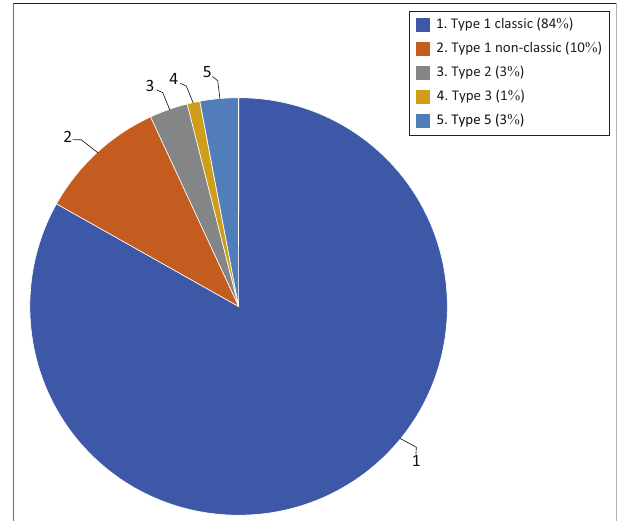
12 FIGURE 6: Coeliac trunk variations: The most common variant types are expressed as a percentage. FIGURE 7: Right renal artery variations: The most common variant types are expressed as a